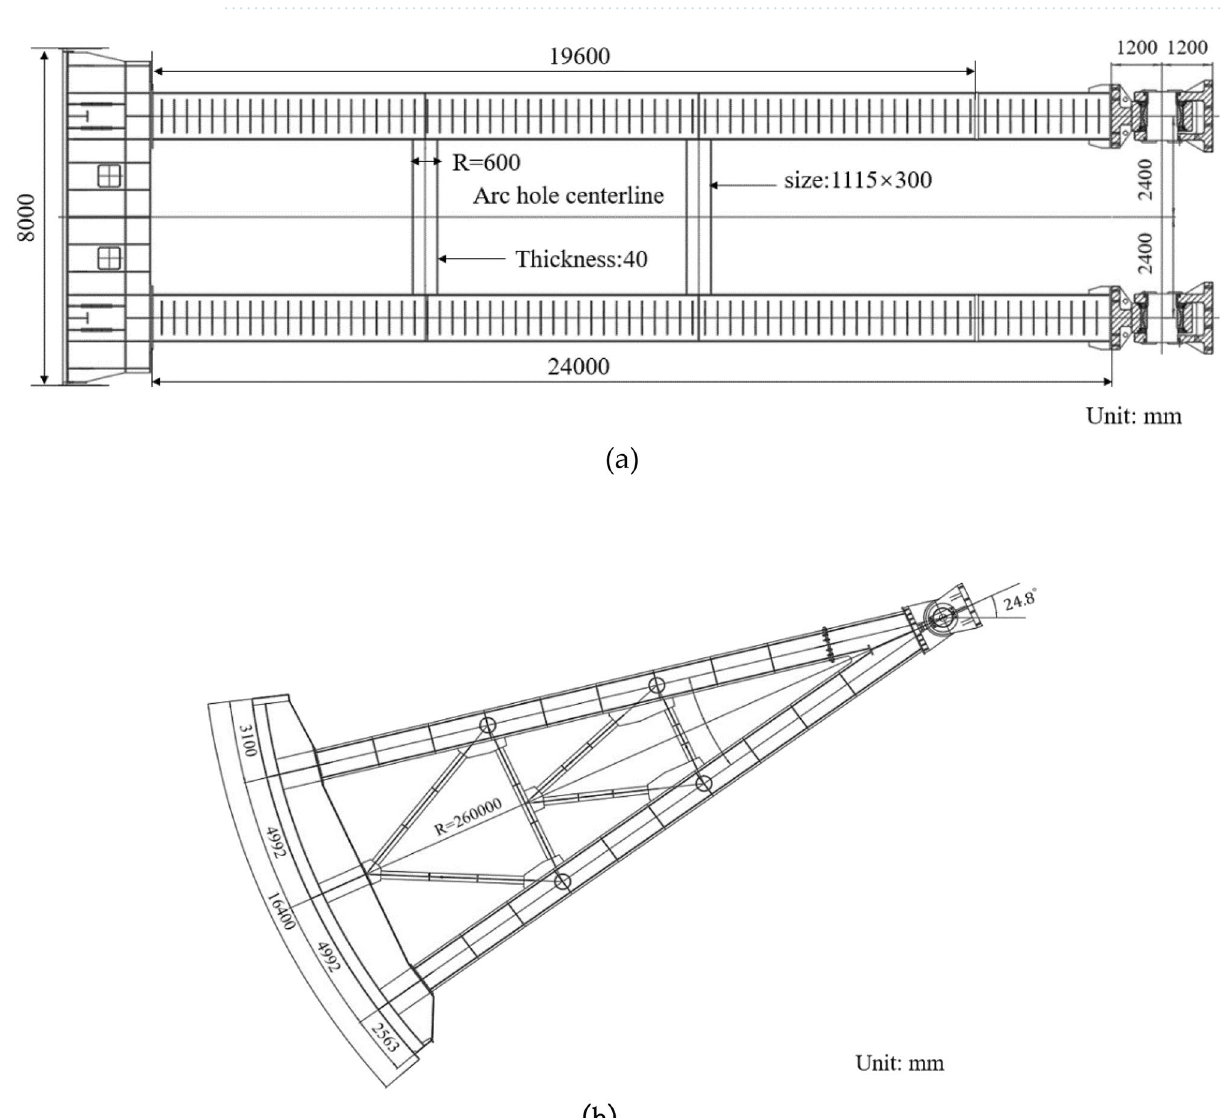
Figure 3. Structural design drawing of radial gate. ( a ) Top view of radial gate, ( b ) Gate structure A-A upstream structural